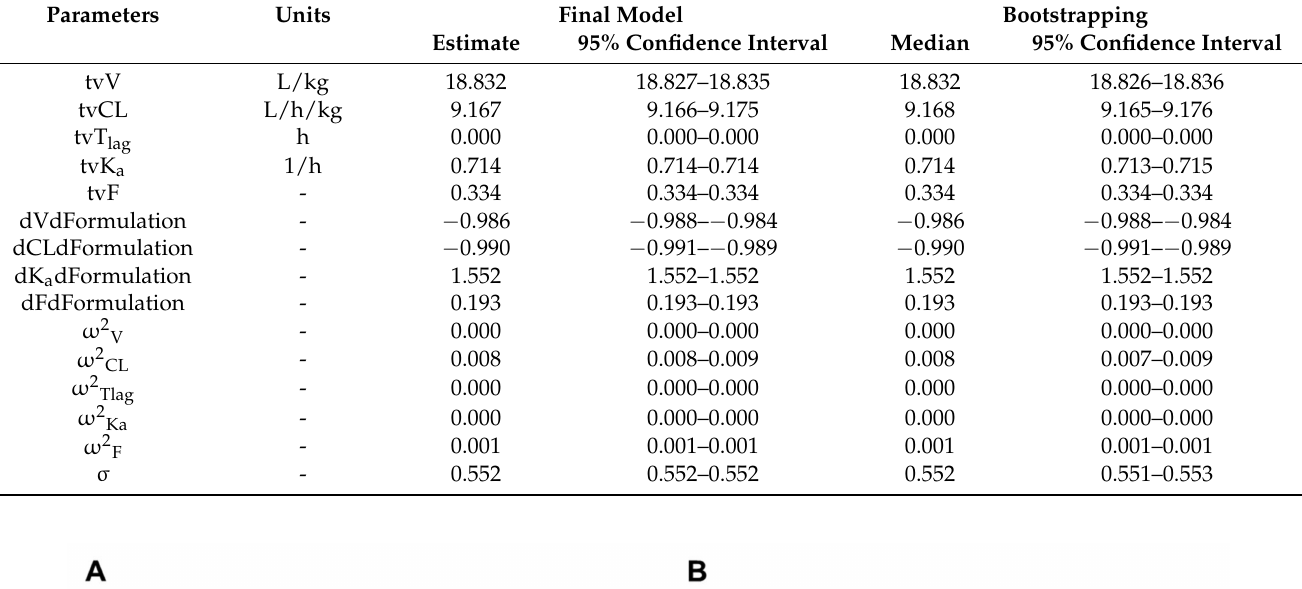
Table 10. Estimated population pharmacokinetic parameter values of methotrexate-loaded nanoformulations, and bootstrap validation ( n = 1000).